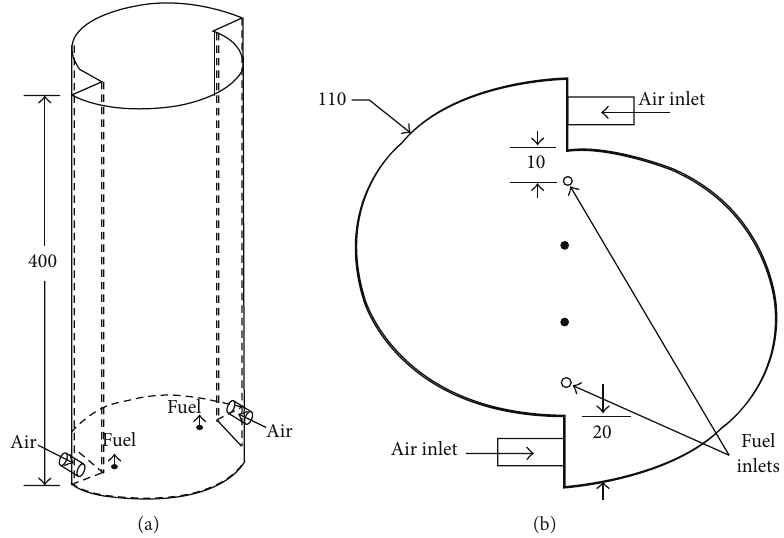
Figure 1: Schematic diagram of the asymmetric combustor: (a) isometric view and (b) top view; all dimensions are in mm.